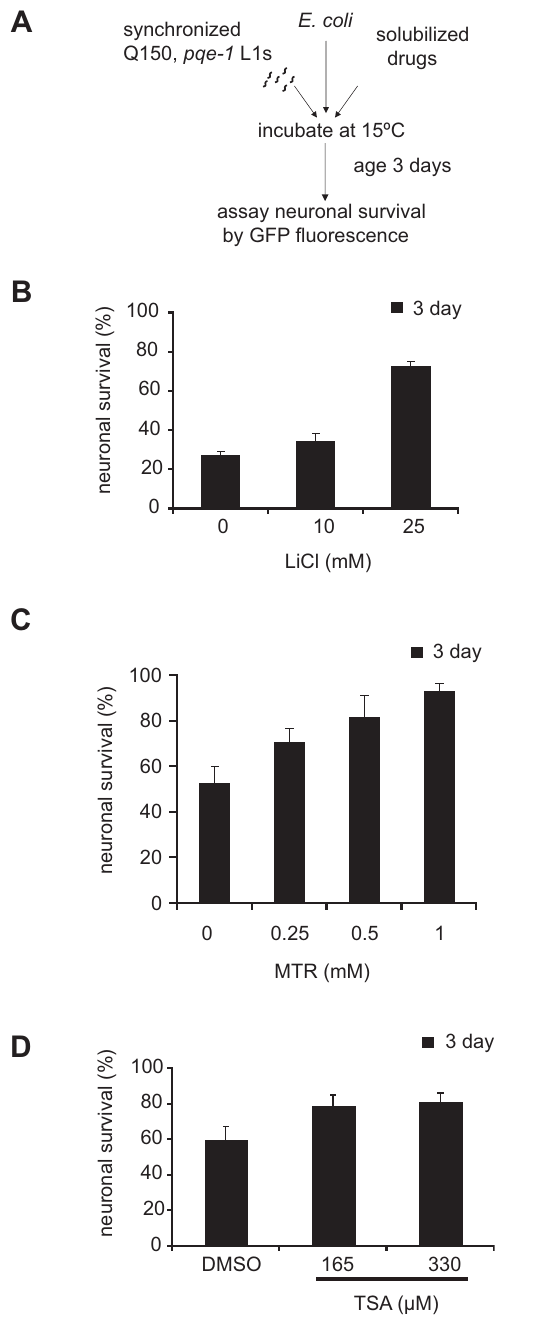
Figure 2. LiCl, TSA, and MTR decrease polyQ mediated ASH neuronal death. (A) Flow diagram of the sensitized assay. 20–30 synchronized pqe-1;Htn-Q150 L1s per well were incubated at 15 u C in S medium with E. coli at an OD (A 595 ) of 0.6 and varying concentrations of compound to a total volume of 60 m l. Animals were grown in the presence of compound for 3 days. ASH neuron survival was evaluated by the presence or absence of GFP expression. (B–D) LiCl, TSA and MTR increased ASH neuron survival in the pqe-1;Htn-Q150 animals in the presence of E. coli . ASH neuron survival was evaluated by the presence or absence of GFP expression on day 3. 100 neurons were scored for each trial; mean percentage of 3 different trials 6 SEM is shown. p , 0.0001 for 25 mM LiCl. p=.037 for 0.5 mM MTR; p , 0.0001 for 1 mM MTR. p=0.0082 for 165 m M TSA; p=0.005 for 330 m M TSA.